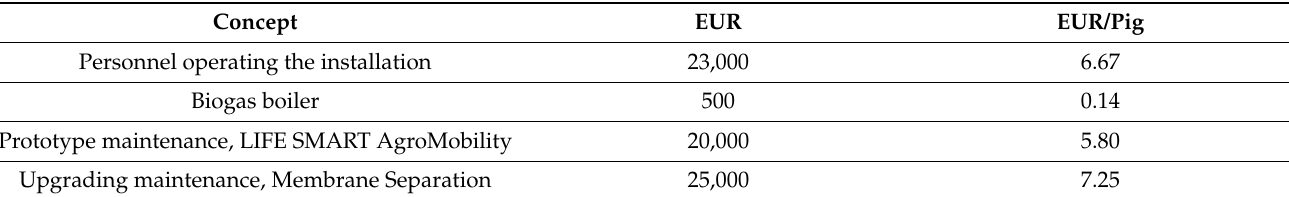
Table 9. Operating costs